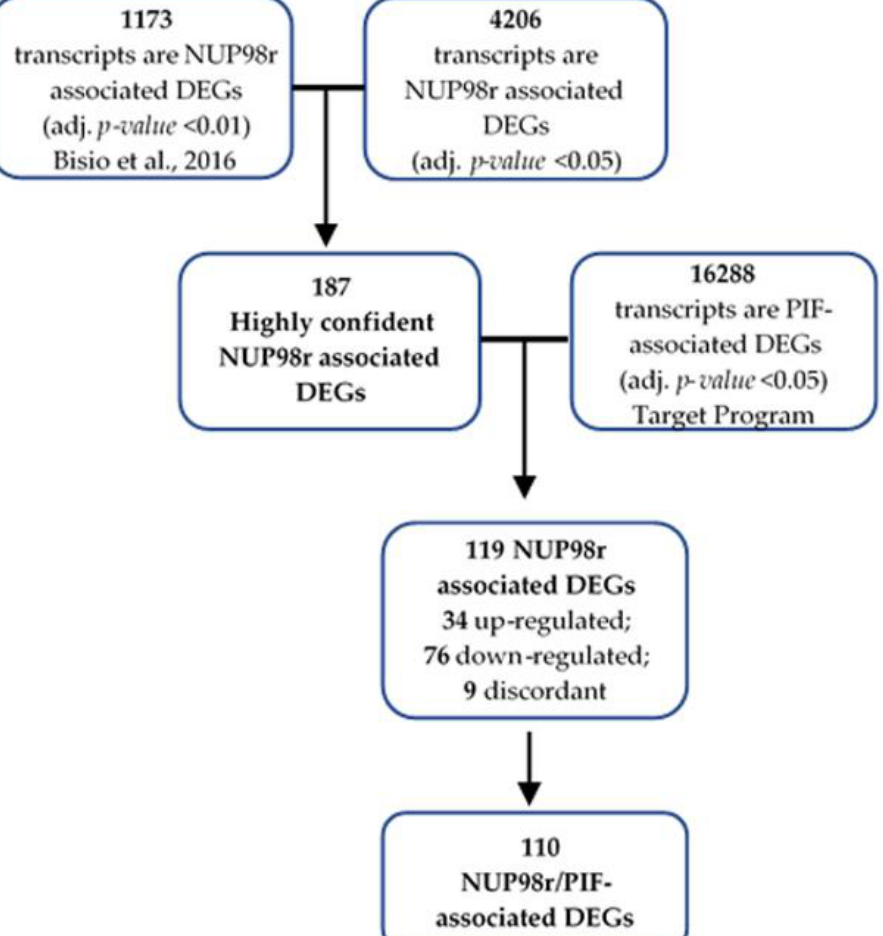
Figure 2. The workflow and overall steps in the integrated analysis in order to identify “NUP98r/PIF-associated DEGs”. The figure shows first 187 highly confident NUP98r associated DEGs, defined as the overlapping fraction between DEGs obtained by analyzing datasets of GSE75461 and TARGET program. Then, overlapping 110 NUP98r/PIF-associated DEGs was obtained.